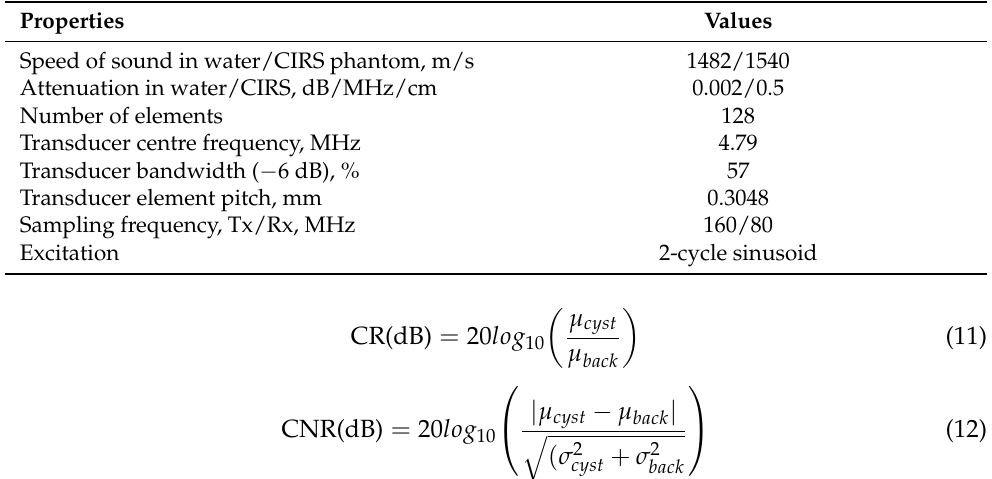
Table 2. Simulation and experimental